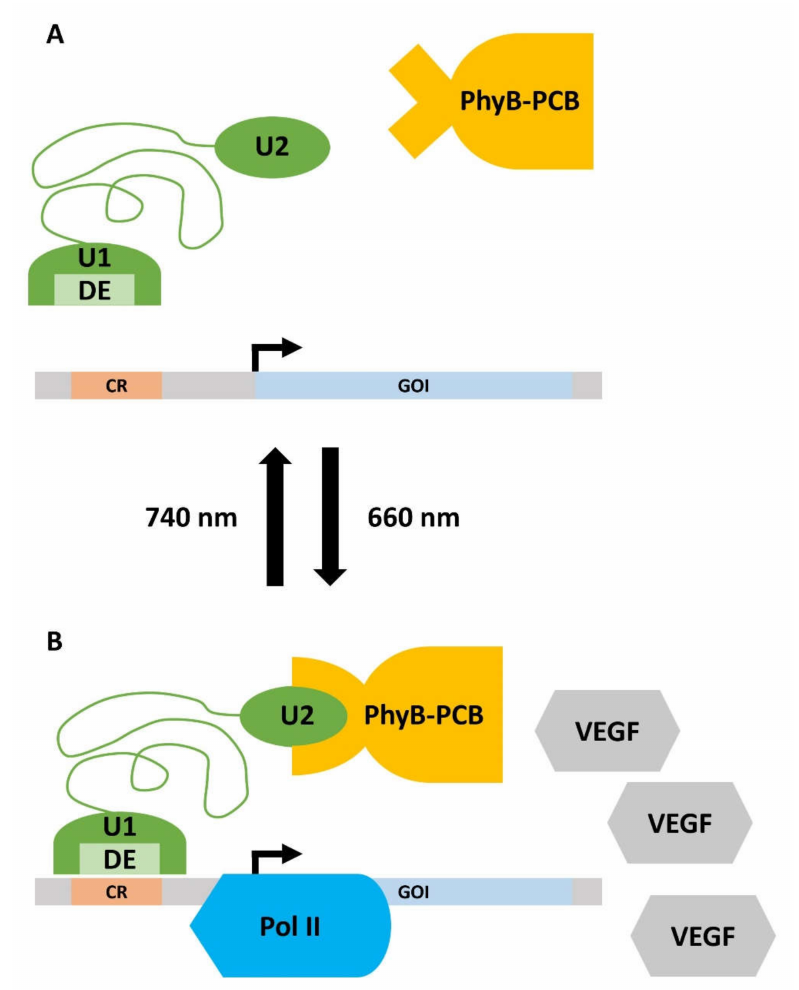
Figure 5. Working principle of the optogenetic gene expression switch. ( A ) Upon irradiation with far-red light (740 nm), the gene expression is turned off. The phycocyanobilin B (PCB), which is bound to phytochromobilin (PhyB), is in a closed conformation and cannot bind to unit 2 (U2) of the split transcription factor (green). Thus, the distinct element (DE) of unit 1 (U1) of the transcription factor does not interact with the certain operator region (CR) on the response vector. Consequently, there is no detectable expression of the gene of interest (GOI). ( B ) Illumination with red light (660 nm) leads to the isomerization of PCB, which induces a conformational change in the PhyB-PCB complex. PhyB-PCB can now recognize U2, which activates the split transcription factor. DE recognizes CR and recruits RNA Polymerase II (Pol II) to the promotor of the response vector. The GOI, in this case, vascular endothelial growth factor (VEGF), is now expressed. Details are given in the main